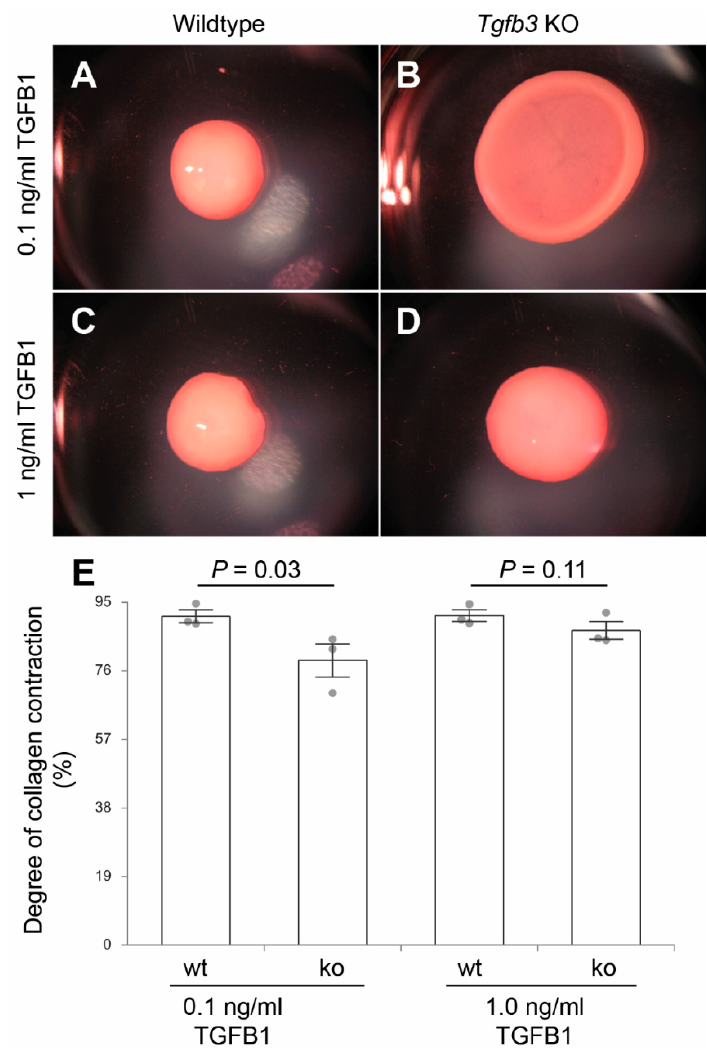
Figure 5. Collagen lattice formation assay. ( A – D ), dissecting microscope images of fibroblast-laden collagen gels after 5-days using three independent fibroblast cell lines ( n = 3) from wildtype ( A , C ) or Tgfb3 − / − embryos ( B , D ) in the presence of low (0.1 ng / mL) ( A , B ) and high (1 ng / mL) ( C , D ) doses of exogenous recombinant TGFB1. TGF β 3-deficient whole mouse embryonic fibroblasts treated with the low dose of exogenous TGFB1 have decreased contractility compared to the wildtype fibroblasts while higher doses rescue contractility and lattice formation ( E ). p -Values are indicated in the histogram. Numerical data are presented as scatter dot-plots with the box denoting the mean; error bars identify the SEM.